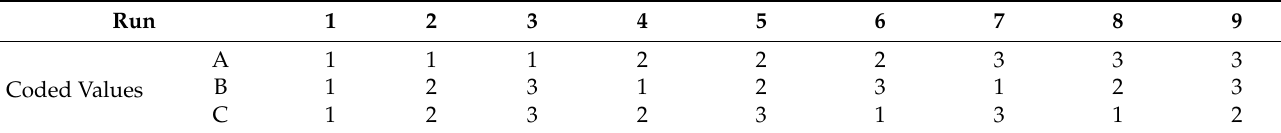
Table 4. Taguchi Orthogonal